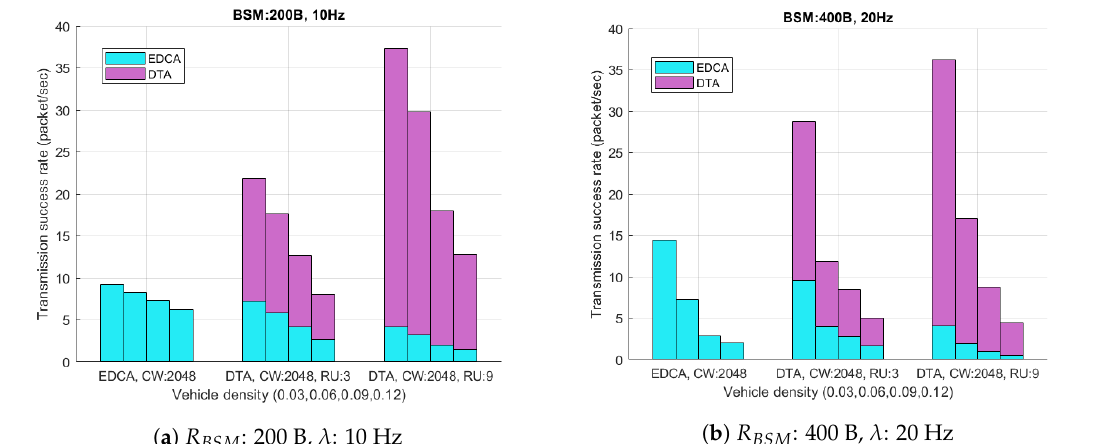
Figure 10. Ratio between DTA and EDCA.